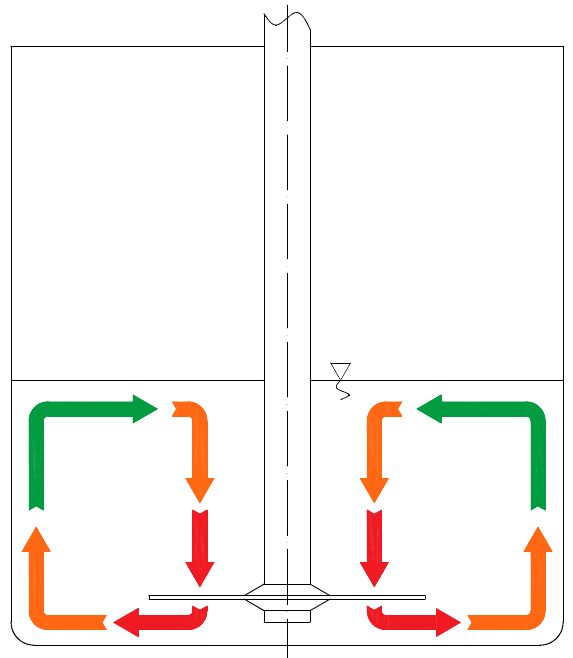
Table 1. Averaged energy dissipation rate and residence time.